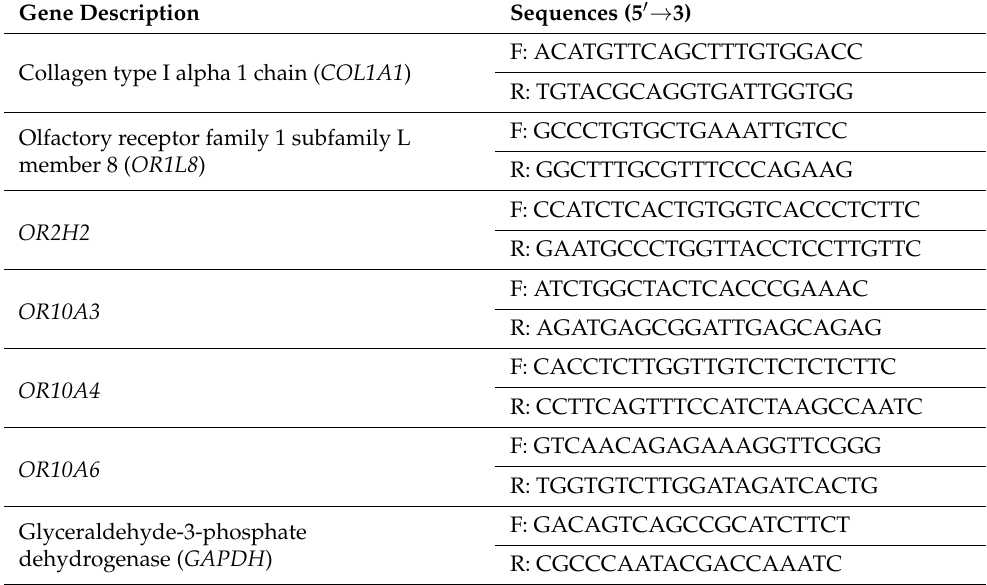
Table 1. Primer sequences used for